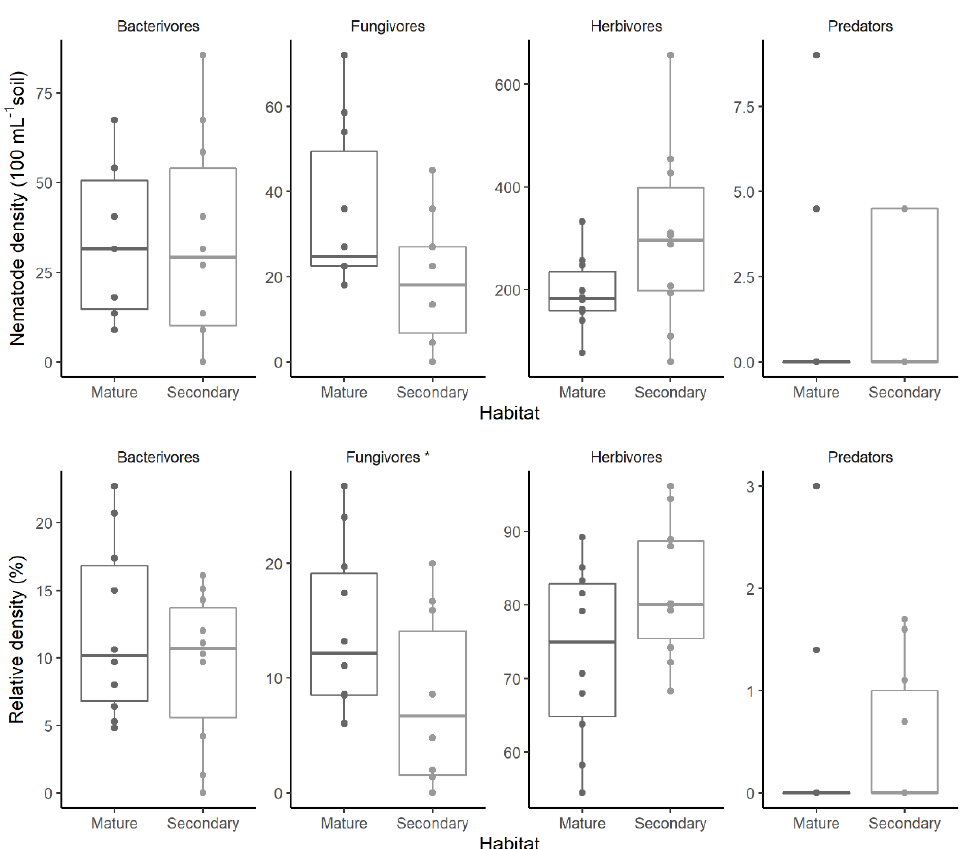
Figure 1. Absolute (upper panels) and relative (lower panels) density of nematodes from different feeding guilds in the rhizosphere of the tropical herb Heliconia collinsiana inhabiting mature continuous forests and secondary forests in southern Mexico. Names with an asterisk indicate significant differences among habitats ( p < 0.05).